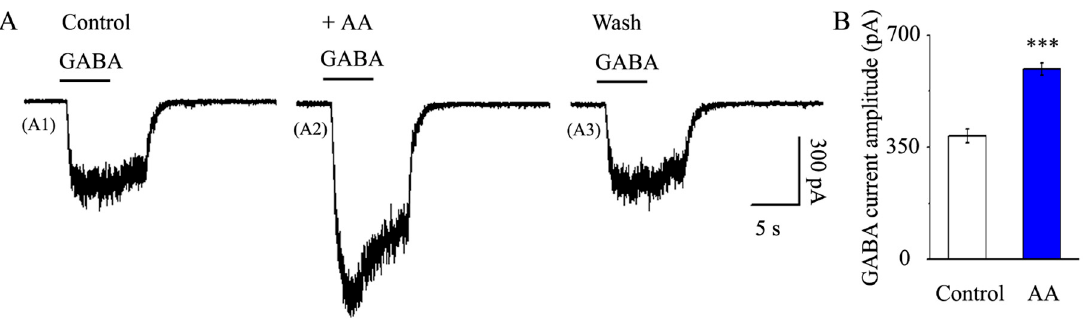
Figure 5. AA increased the GABA-induced current amplitude in glaucomatous RGCs. ( A ) Repre- sentative large-scale traces demonstrating the effect of 10 μ M AA on GABA-induced postsynaptic receptor current during AA treatment ( A2 ), recovery ( A3 ) and control conditions ( A1 ). Scale bars: vertical, 300 pA; horizontal, 5 s. ( B ) The amplitude of the postsynaptic receptor current generated by GABA under control and after AA treatment. Student’s paired t -test; *** p < 0.001 compared with the control conditions.